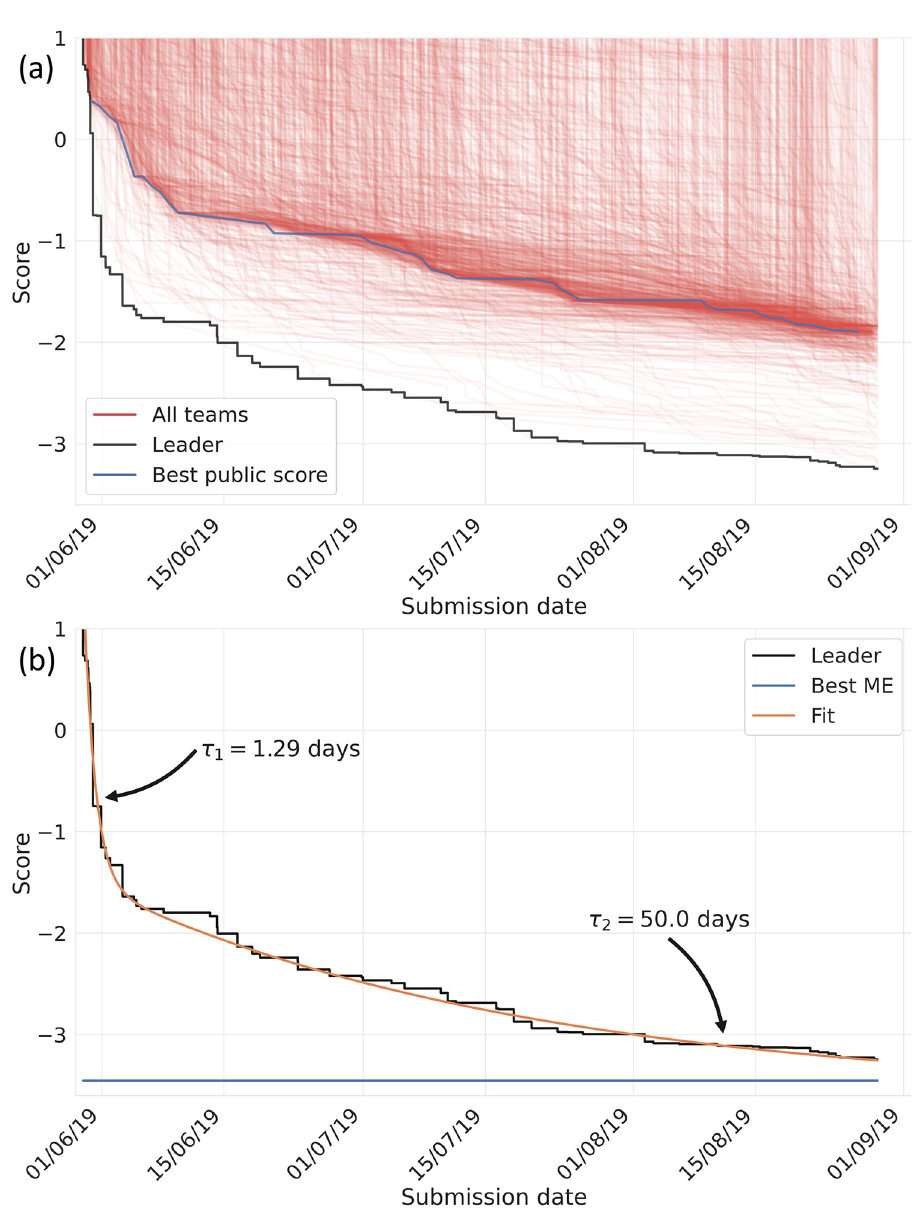
Fig 2. (a) score evolution vs. time. Black line shows the best performing method vs. time. Blue line shows the best performing public notebook. Red lines shows the best submission by each team; (b) best fit of the time dependent leader (black) score to an biexponential curve of the form A � exp( − t / τ 1 )+ B � exp( − t / τ 2 )+ C ( A = 2.11; B = 2.97; τ 1 = 50.0 days; τ = 1.29 days; C = -3.59). Blue indicates the best ME model 2